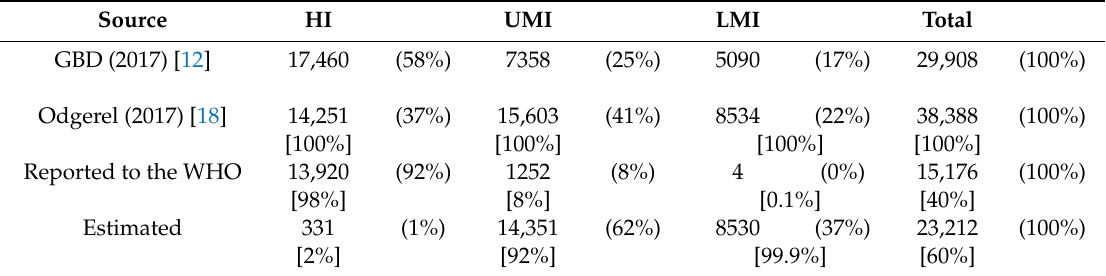
Table 3. Distribution of global mesothelioma deaths across countries by national income category